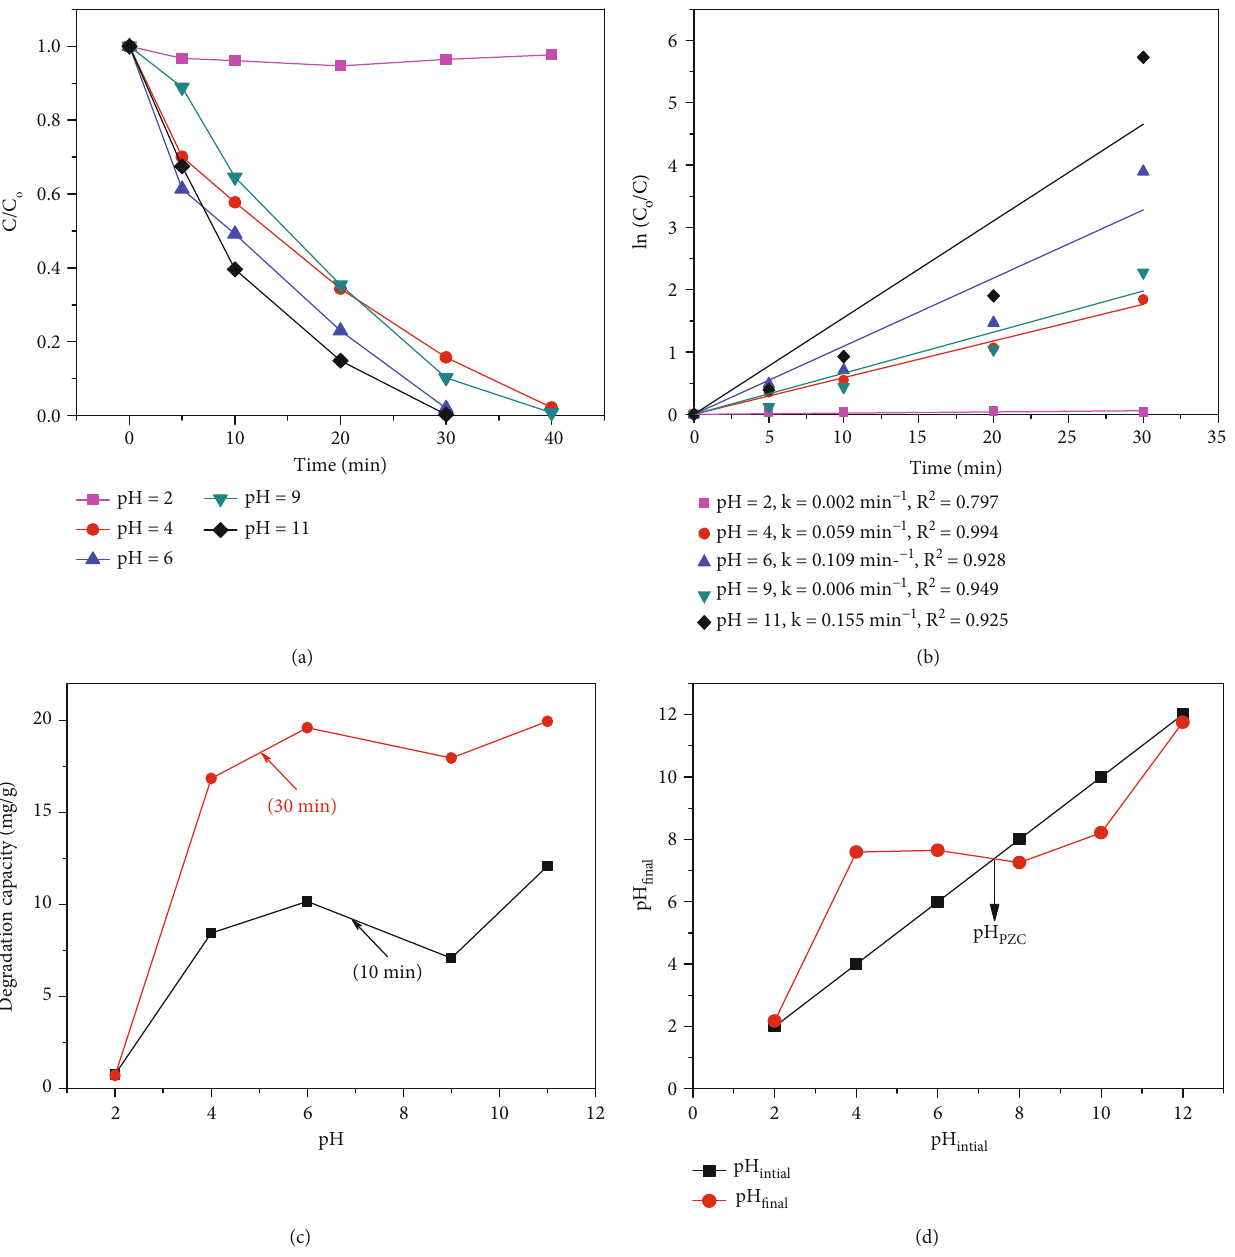
Figure 9: (a) E ff ect of solution pH on photodegradation of TA, (b) the kinetic curves, (c) the DC of Au/ZnO-5 composite, and (d) determination of pH of Au/ZnO-5 composite. The reaction conditions: catalyst dosage of 0.5g/L, TA concentration of 10 mg/L, and ZPC Hg lamp